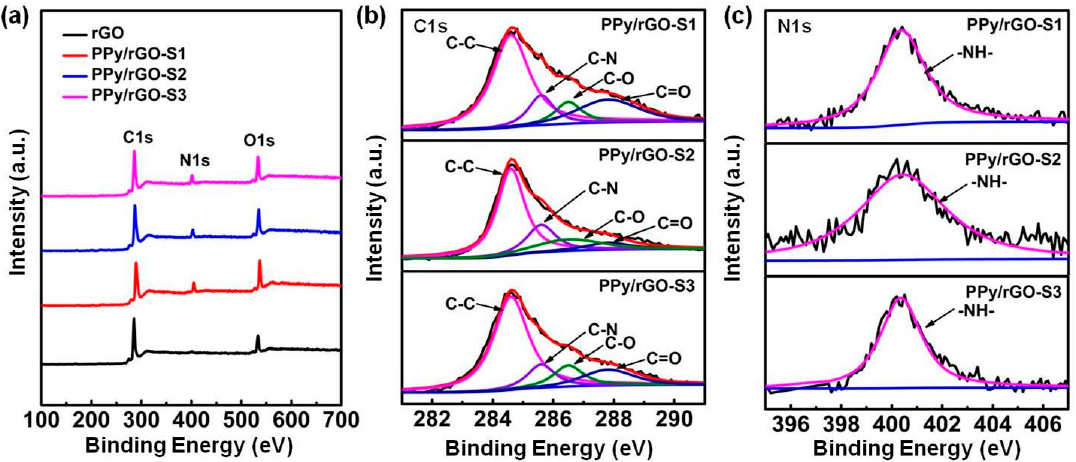
Figure 5. XPS wide-scan spectra of rGO, PPy/rGO-S1, PPy/rGO-S2, and PPy/rGO-S3 ( a ); C1s core-level spectra of PPy/rGO-S1, PPy/rGO-S2, and PPy/rGO-S3 ( b ); N1s core-level spectra of PPy/rGO-S1, PPy/rGO-S2, and PPy/rGO-S3 ( c ).